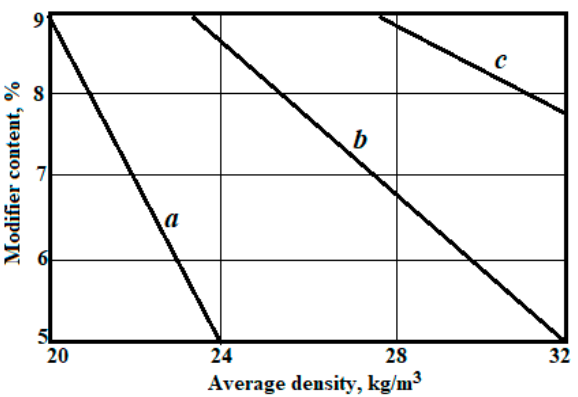
Figure 6. Dependence of the average density of polyethylene foam with optimised-flame retardant consumption on variable factors, with the content of recycled polyethylene: a—10 kg/m 3 ; b—20 kg/m 3 ; c—30 kg/m 3 .